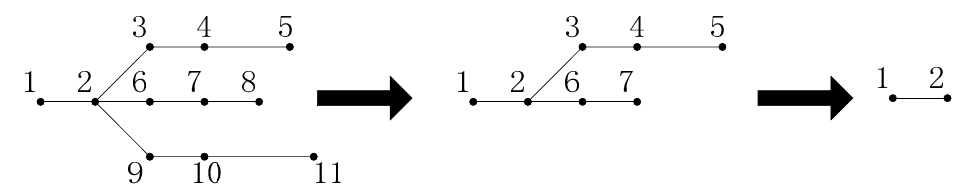
Figure 2. The topology change after deleting grade-1 buses.